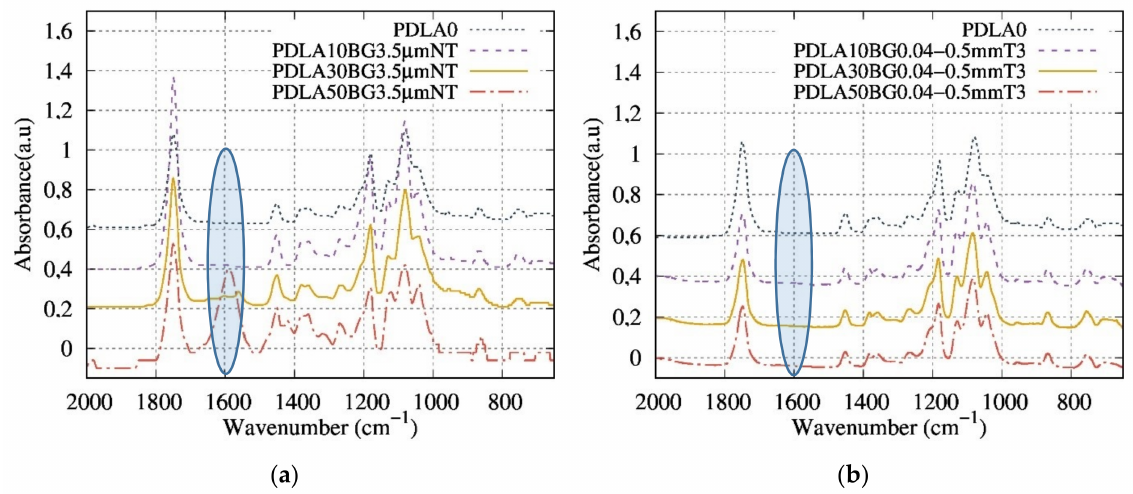
Figure 5. Superposition of ( a ) FTIR spectra of composites containing various contents of BG 3.5 µ m NT (wt%); ( b ) FTIR spectra of composites containing various contents of BG 0.04–0.5 mm T3